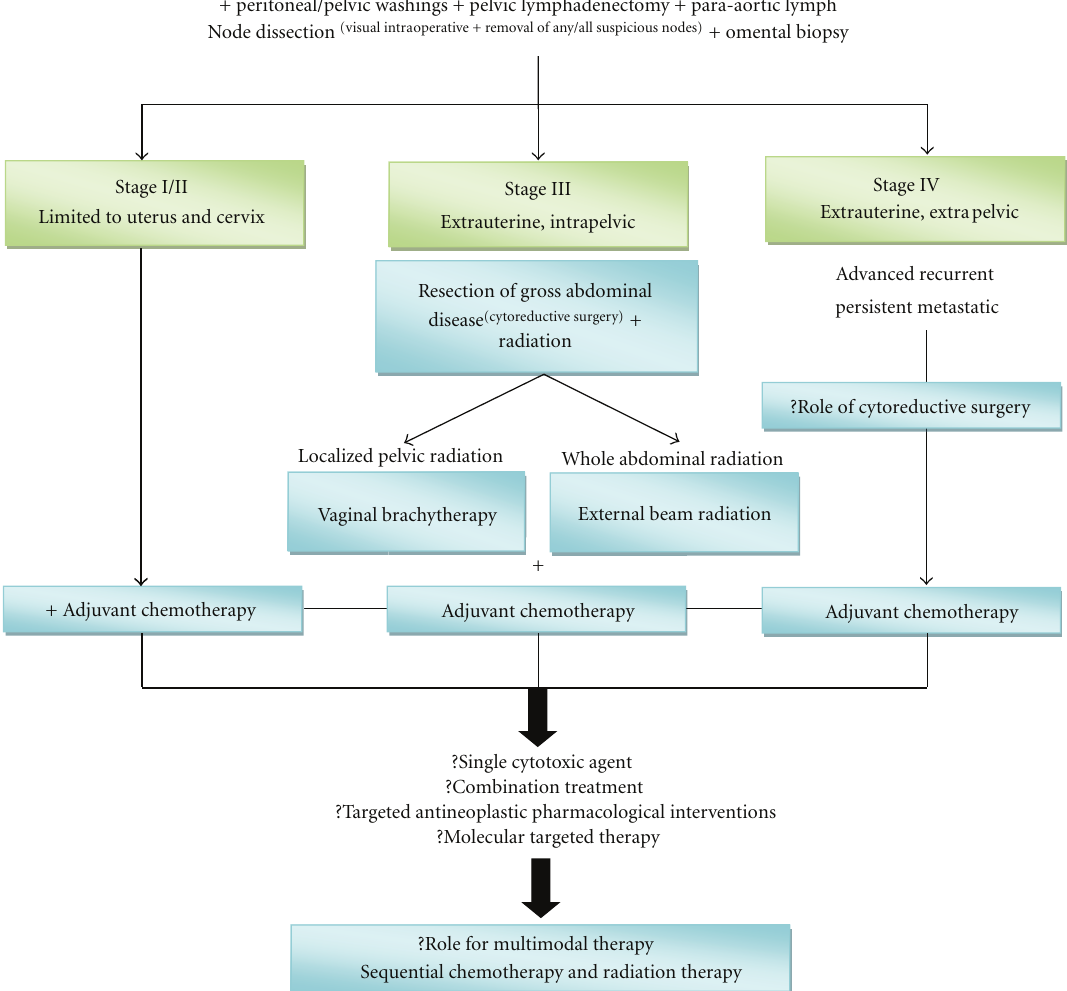
Figure 5: This flow chart summarizes the current recommendations for the treatment of uterine carcinosarcomas. Due to the rapidly progressive nature of this neoplasm, we recommend adjuvant chemotherapy even in Stage I/II lesions as we believe that the late clinical presentation of these cases is usually associated with silent microscopic disseminated disease. Uncertainties regarding the value of aggressive cytoreductive surgery in Stage IV disease are questionable and indicated with “?”. Similarly, the most e ff ective protocol for chemotherapy is also unknown and indicated by “?”. Likewise, the role for multimodal therapy in this neoplasm is yet to be determined